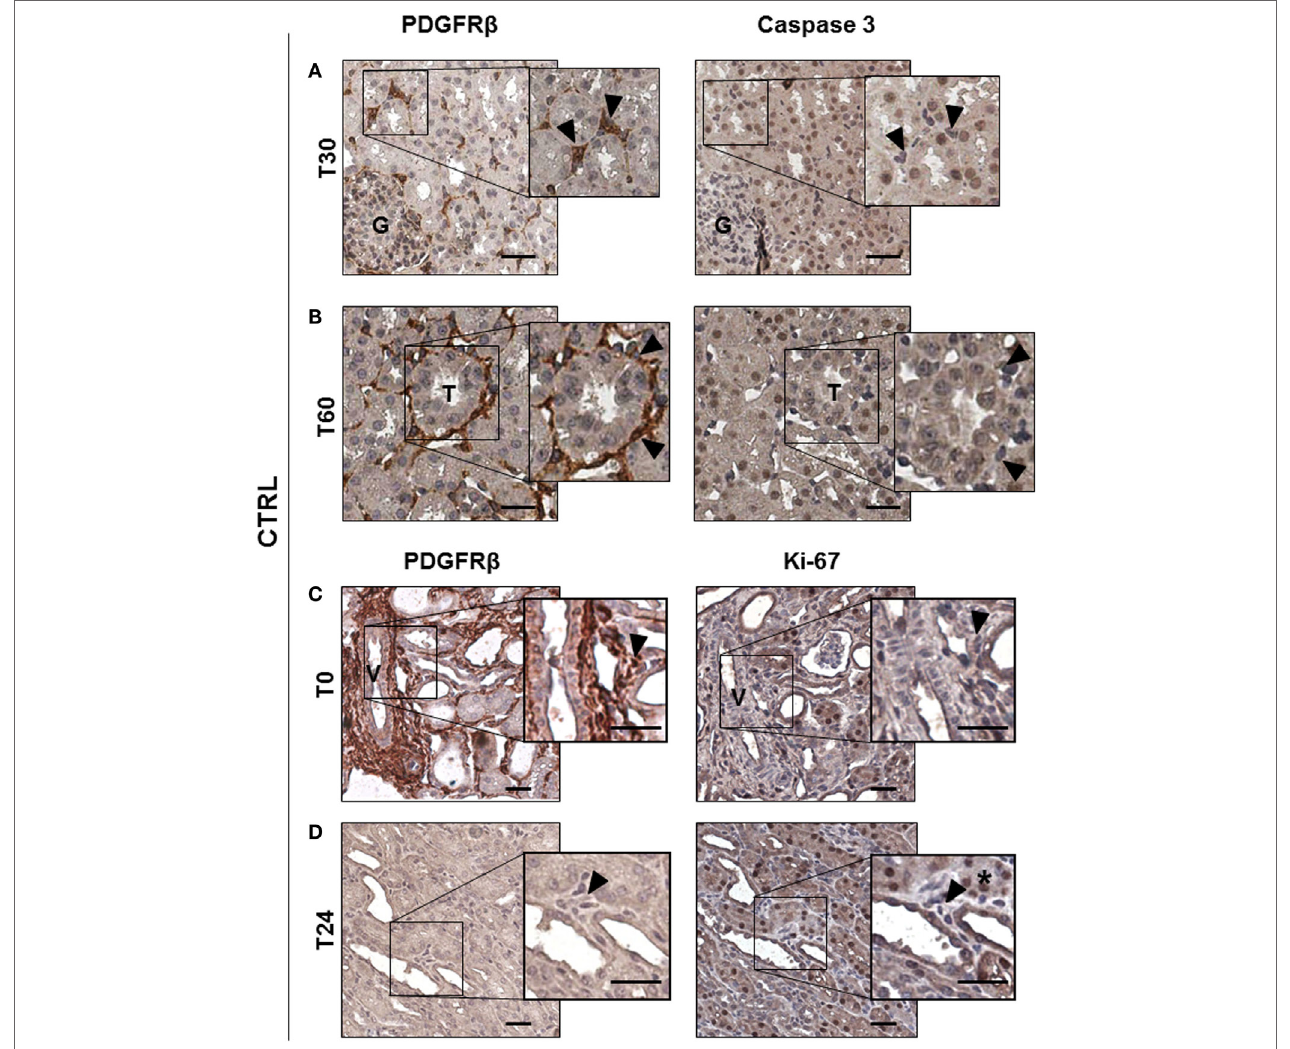
FigUre 3 | Ischemia/reperfusion injury did not induce pericytes apoptosis in vivo . IHC analysis of CTRL group serial sections labeled for PDGFR β and Casp3 (a,b) and for PDGFR β and Ki-67 (c,D) . PDGR β + peritubular capillaries-cells were detected by brown cytoplasmic staining. Apoptotic Casp3 + -cells shown nuclear brown signal, while Casp3 − cells had blue nuclei. Double positive PDGFR β + /Casp3 + peritubular pericytes were barely detected at early time after reperfusion [T30 in (a) and T60 in (b) ], boxed area was enlarged at right . Magnification 20 × , scale bar = 50 μ m. Arrowheads indicate representative PDGFR β + -pericytes (brown cytoplasmic cells) that showed negative Casp3 in the right panel. Immunohistochemical split diagram showing PDGFR β + /Ki-67 − peritubular cells at T0 and T24h (c,D) . Arrowheads indicate representative PDGFR β + -pericytes that did not show positivity for Ki-67 staining (blue nuclei) [ (c) , right ]; arrowheads indicate not proliferating perivascular cells [ (D) , right ]; asterisk indicates Ki-67 + tubular cells. G, glomeruli; T, tubuli; V,